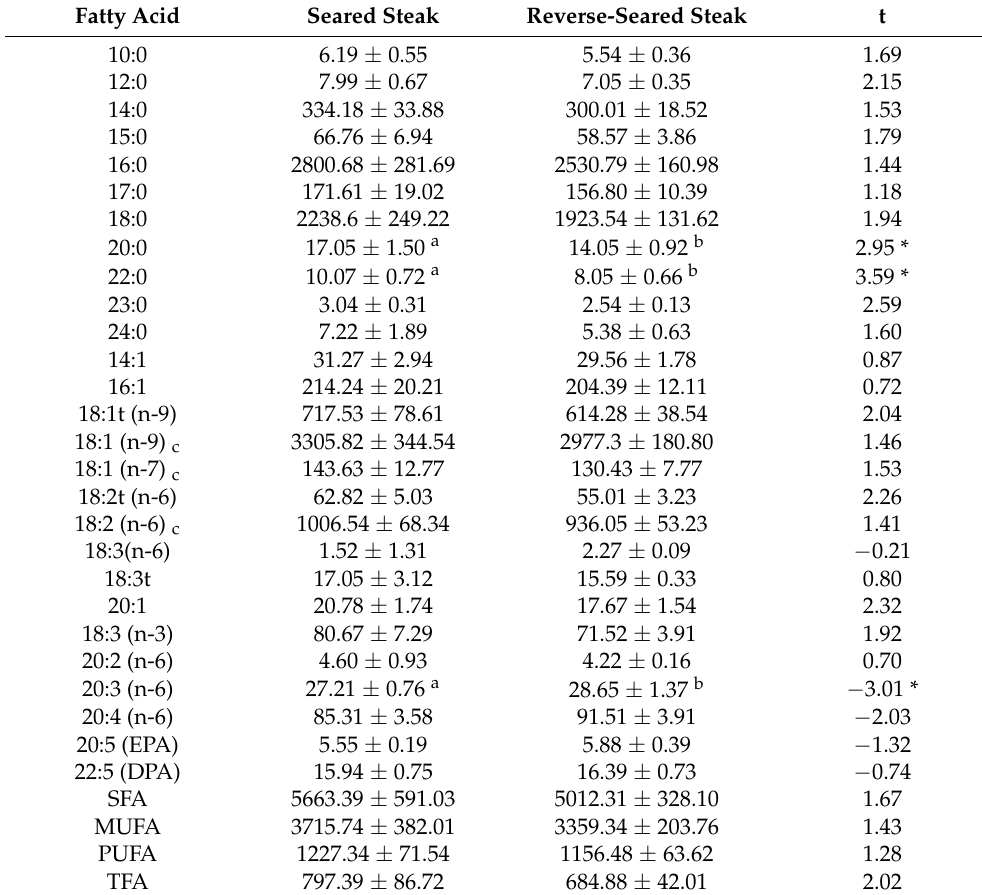
Table 3. Fatty acids (mg/100 g) of seared and reverse-seared